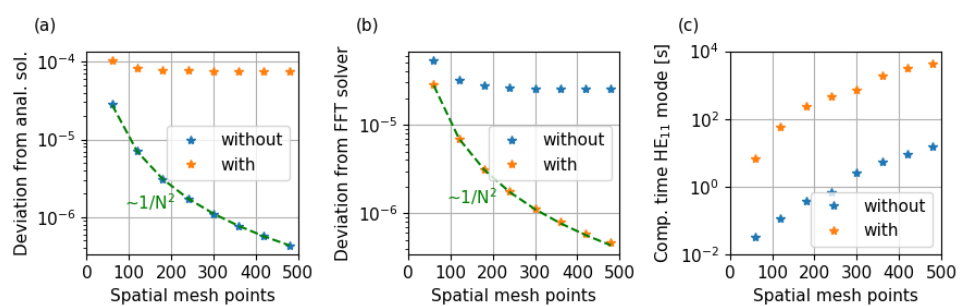
Figure 3. Results of the DHT-based mode solver regarding the HE 11 mode in a graded-index fiber design, either with or without the terms that scale with ∂ / ∂ρ ln ( (cid:101) ) in Equations (12) and (13). ( a ): Absolute deviation from the analytically computed propagation constant of the linearly polarized modes. ( b ): Absolute deviation from the propagation constants computed by a 2D FFT-based full- vectorial mode solver. ( c ): Required computational times. As before, the dashed 1/ N 2 trend lines are not fitted but only guides to the